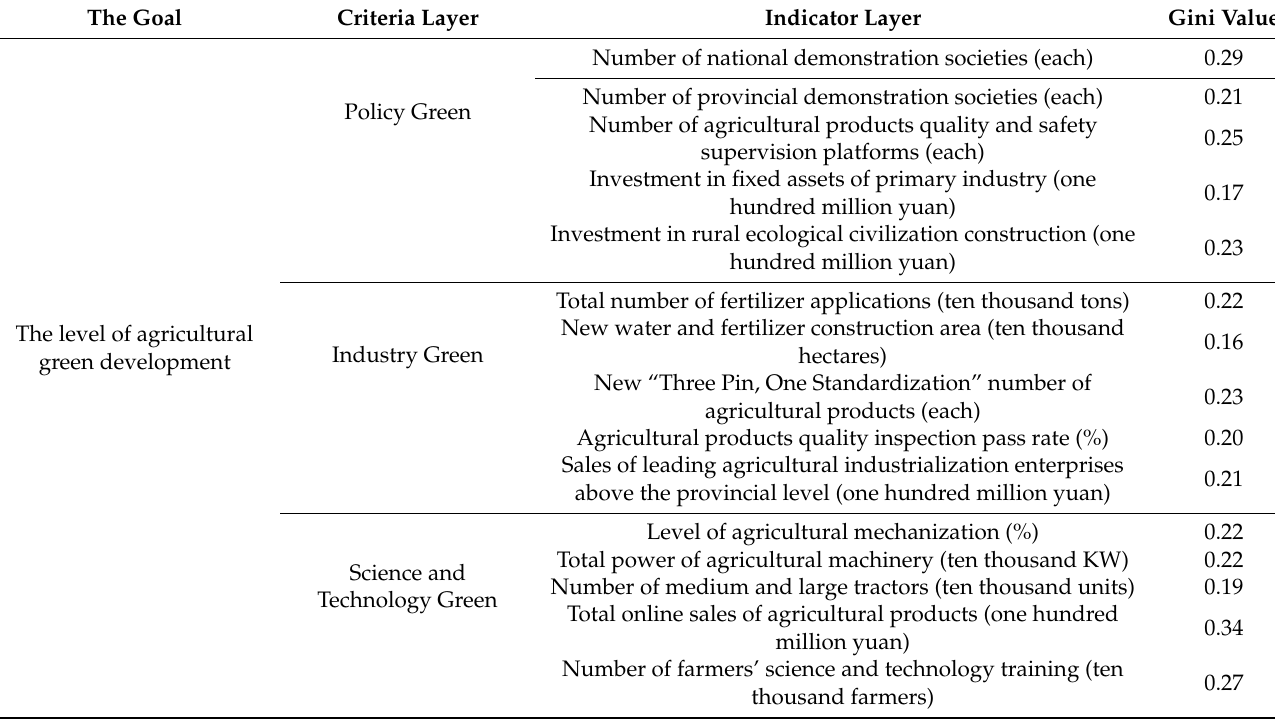
Table 3. Quantitative sea selection indicator system and Gini